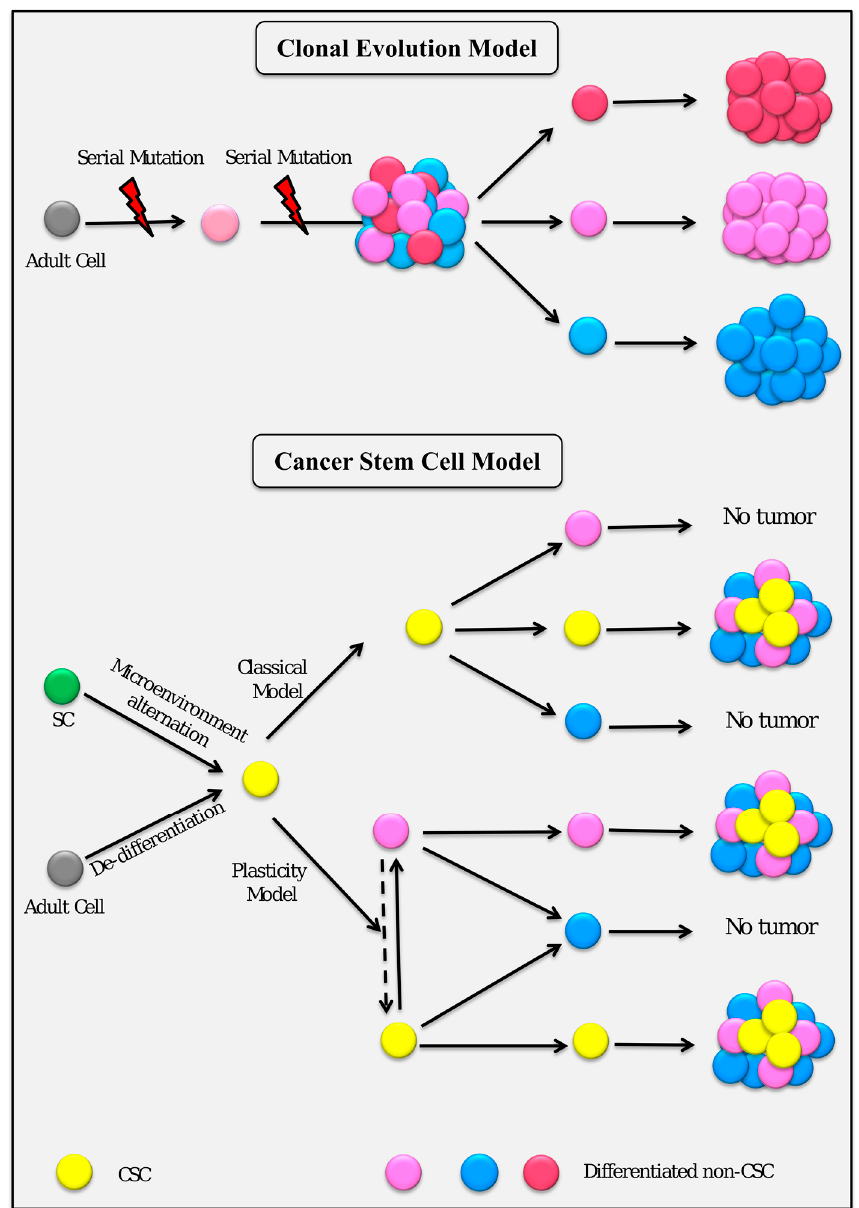
Figure 1. Schematic illustration for the stochastic and cancer stem cell (CSC) models of tumorigenesis.